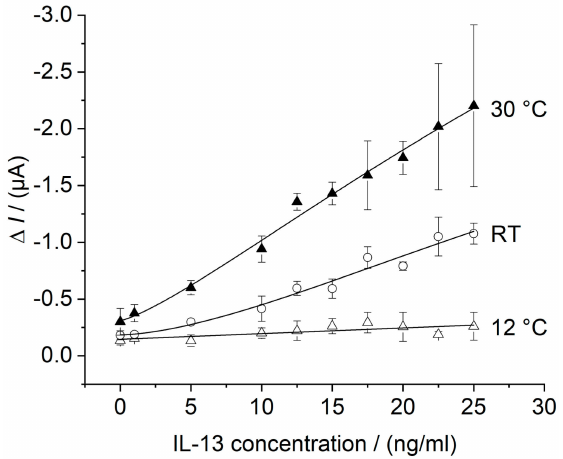
Figure 8. Calibration curves of the IL-13 immunosensor in thermostat-controlled flow cell. Three different immunosensors prepared in the same manner (triplicates) for each concentration. Amperometric measurements performed at 0.0 V. Measurements in flow cell with continuous flow of 1 mM hydroquinone in 0.1 M PBS pH 6 with 0.8 mL/min, injection flow of 1.5 mM hydrogen peroxide in 0.1 M PBS pH 6 with 0.4 mL/min and injection volume of 100 µ L. Measurements conducted at 12 ◦ C (white triangles) and at 30 ◦ C (black triangles). Measurements without temperature control (i.e., at RT = room temperature) from Figure 7 (white circles) are shown for comparison. Calibration curve at 12 ◦ C was fitted with a linear model, whereas the calibration curves at RT and 30 ◦ C were fitted with the 4-parameter logistic model, as described in Section